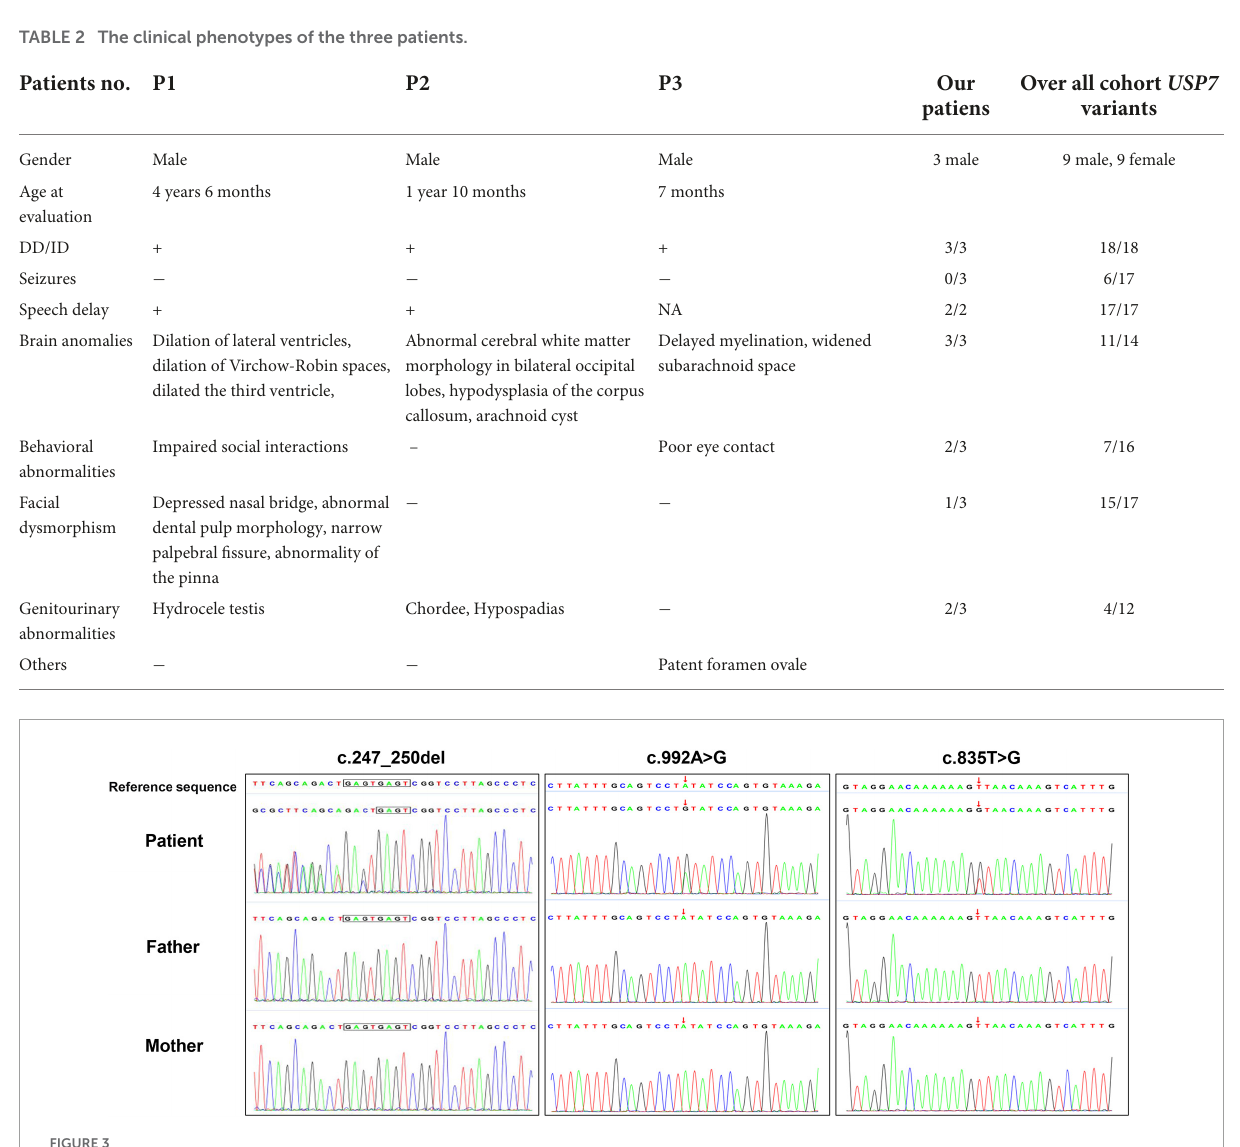
FIGURE3 The de novo USP7 variants were confirmed using Sanger